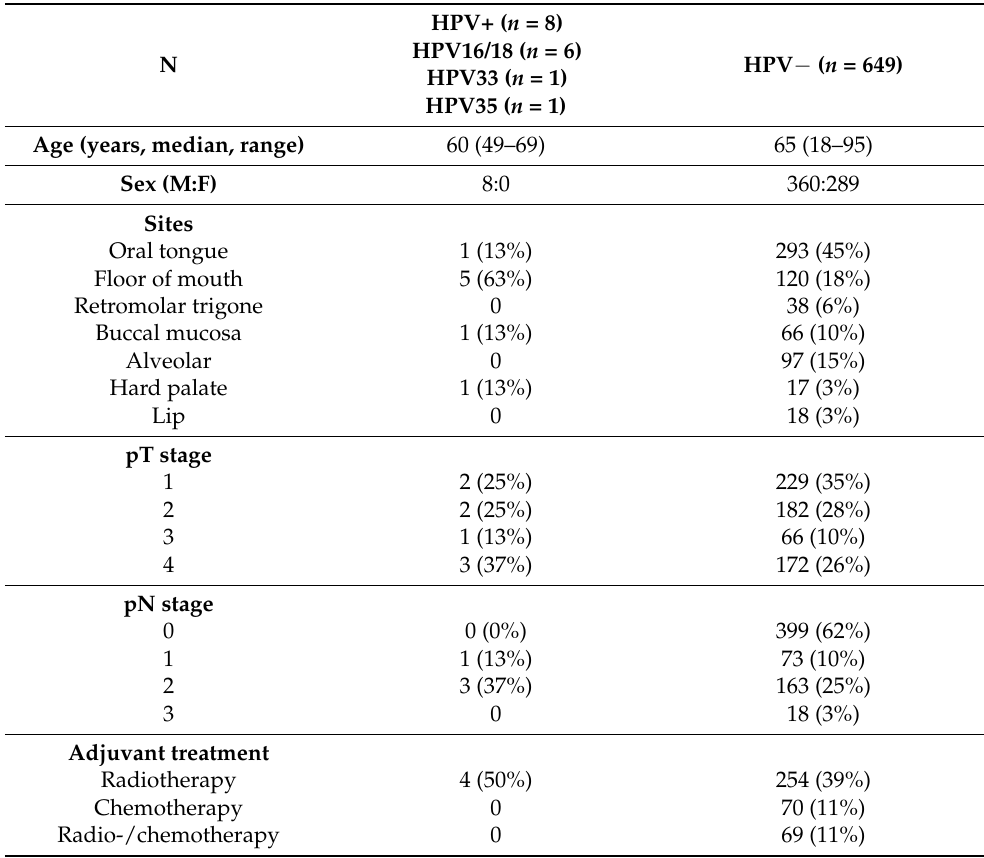
Table 3. Demographics by HPV